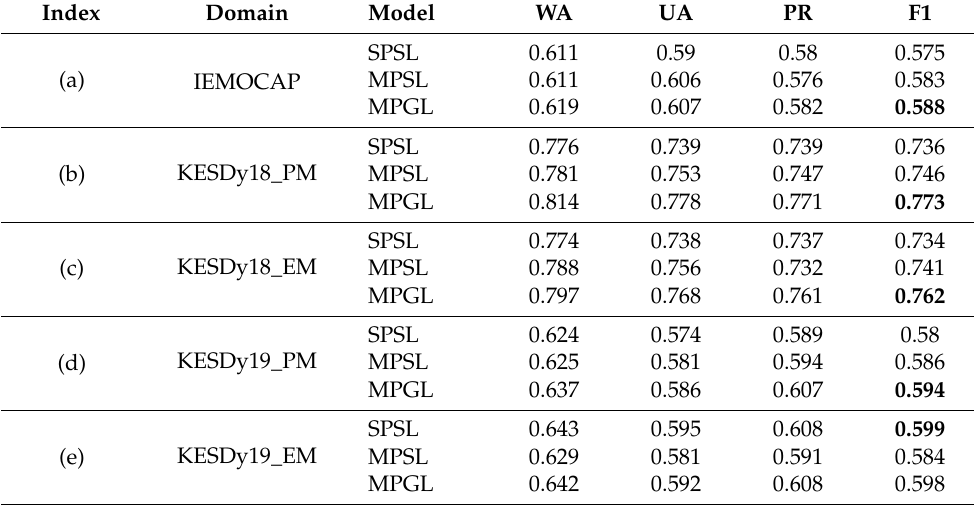
Table 6. Evaluation results in a single domain dataset. Single-path-single-loss (SPSL) is the baseline SER model that learns by the temporal embedding features and the loss L cd ; Multi-path-single-loss (MPSL) is that model learns using the multi-path embedding vectors and loss L cd without the loss L cv ; MPGL is the model that learns based on multi-path embedding vectors and the group loss L g